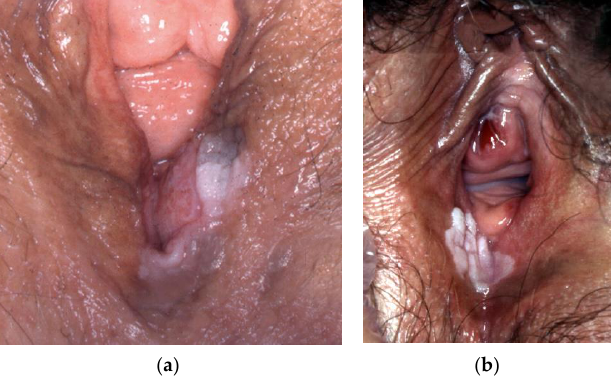
Figure 23. ( a ) dVIN, ( b ) dVIN.